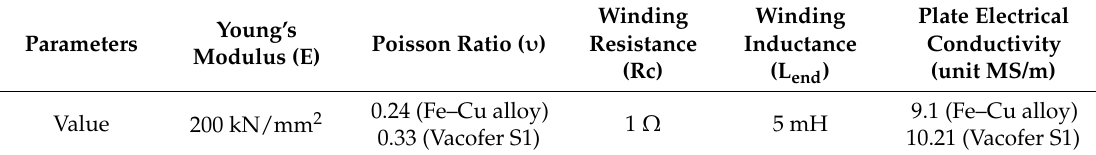
Table 2. Mechanical and electrical parameters of the